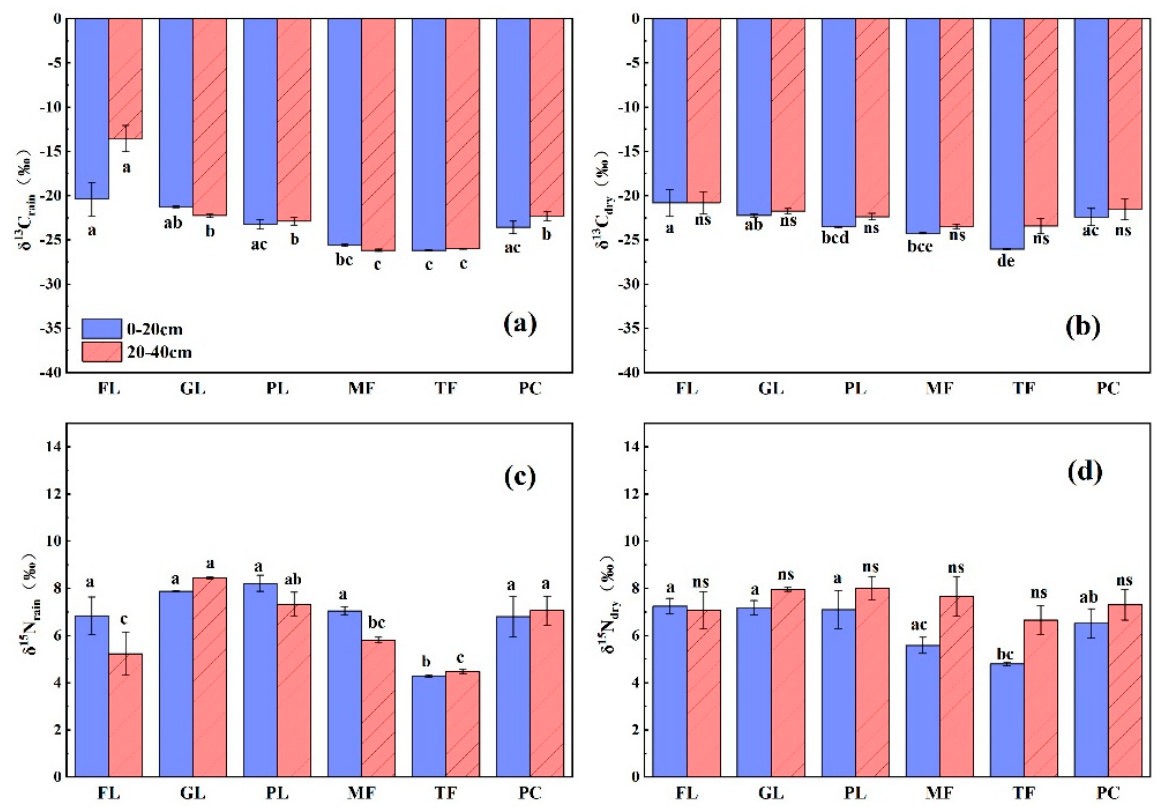
Figure 2. Mean values of δ 13 C and δ 15 N for the 0–20 cm and 20–40 cm soil layers of the six land use types in the rainy and dry seasons. ( a ) δ 13 C rain , δ 13 C value of rainy season soil; ( b ) δ 15 N rain , δ 15 N value of rainy season soil; ( c ) δ 13 C dry , δ 13 C value of dry season soil; ( d ) δ 15 N dry , δ 15 N value of dry season soil. Different lowercase letters indicate significant differences in δ 13 C values ( δ 15 N values) of different land types in the same soil layer at the p < 0.05 level, while ns indicates no significant differences.